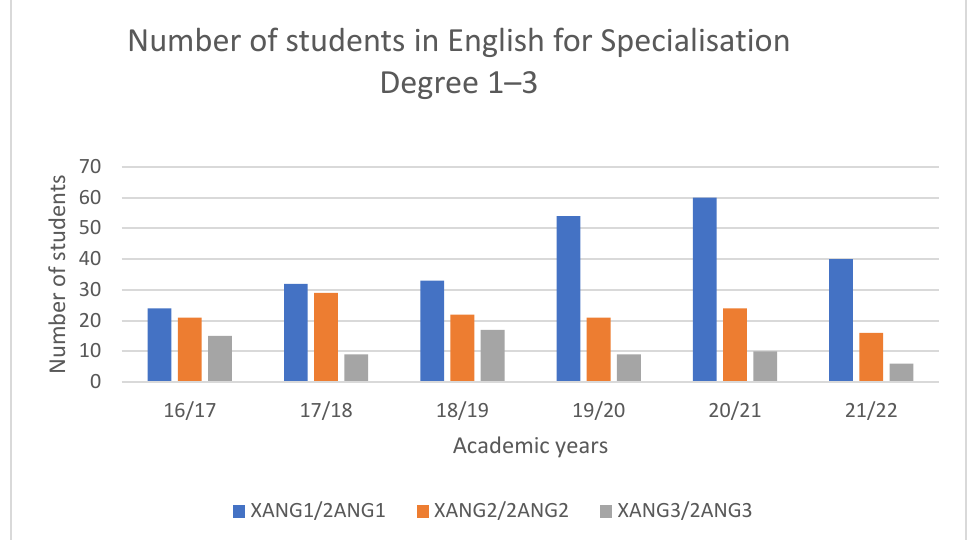
Figure 11. Number of combined and distance students enrolled in XANG1-3 in period 2016 – 2022.